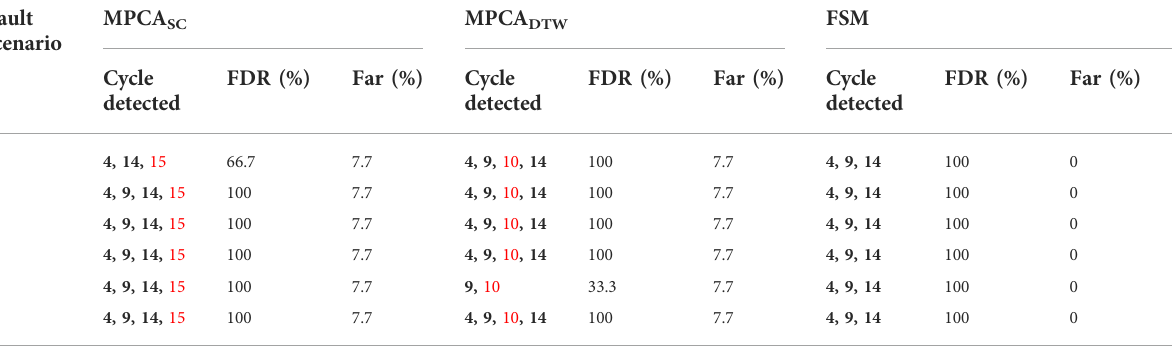
TABLE 3 Fault detection results (true faulty cycles: 4, 9 & 14; FDR: fault detection rate; FAR: false alarm rate). Correctly detected cycles are in bold black. Incorrectly detected cycles are in red. Fault scenario